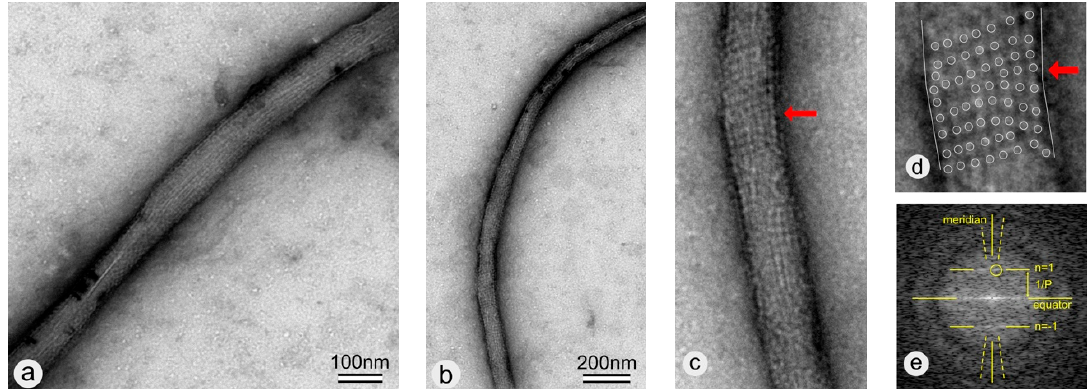
Figure 5. ( a , b ) TEM images of negatively stained wtSbpA coated MWNTs. The wtSbpA coating exhibits a crystalline lattice with square lattice symmetry. ( c ) Zoomed view of the lower end of the S-layer coated MWNT shown in ( b ). Note the lattice defect in the S-layer lattice (marked by the red arrow) where the MWNT buckles in ( c ) and in the further zoomed view in ( d ) where the unit cell positions are marked by circles too. ( e ) Fourier spectrum of a straightened copy of ( c ) showing the layer lines n = ± 1 and in this way the corresponding pitch P of the helical S-layer.